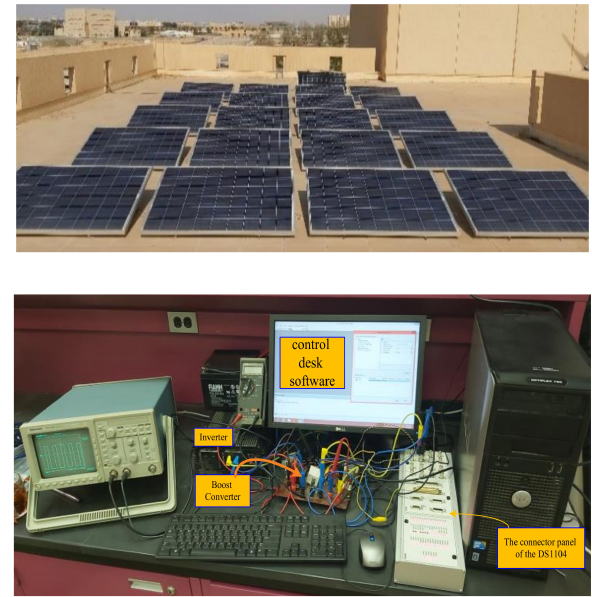
Figure 13. The picture of the experimental